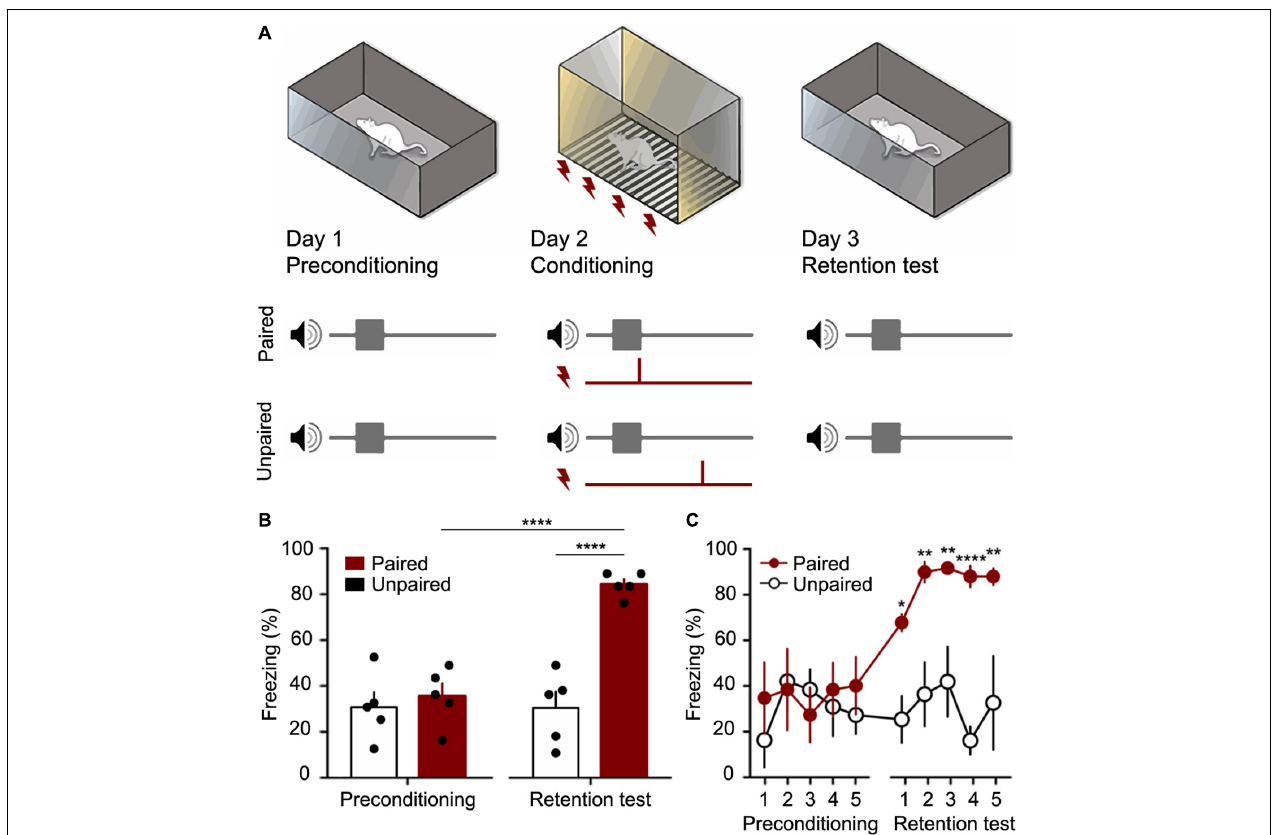
FIGURE 6 | The Fear conditioning protocol (CFC) was performed as a proof of concept for the customized chamber. (A) Preconditioning occurred in Day 1, when 5 trials of CS (10 kHz pure tone with its amplitude modulated by a sine wave of 53.7 Hz) were presented to the animals in a context A. The Conditioning occurred in Day 2, when 5 trials of CS and US (a footshock with 400 µ A over 2 s) were presented to the Paired and Unpaired groups using the customized chamber. In Day 3, retention test occurred with 5 trials of CS being presented to both groups. Animal fear response (freezing) was measured in order to verify if the association between sound and shock. (B) Total mean freezing ( ± SEM) to CS in preconditioning and test sessions. (C) mean freezing ( ± SEM) to CS over trials. ∗ p < 0.05, ∗∗ p < 0.01, ∗∗∗∗ p < 0.0001. 2-way ANOVA followed by Bonferroni post hoc